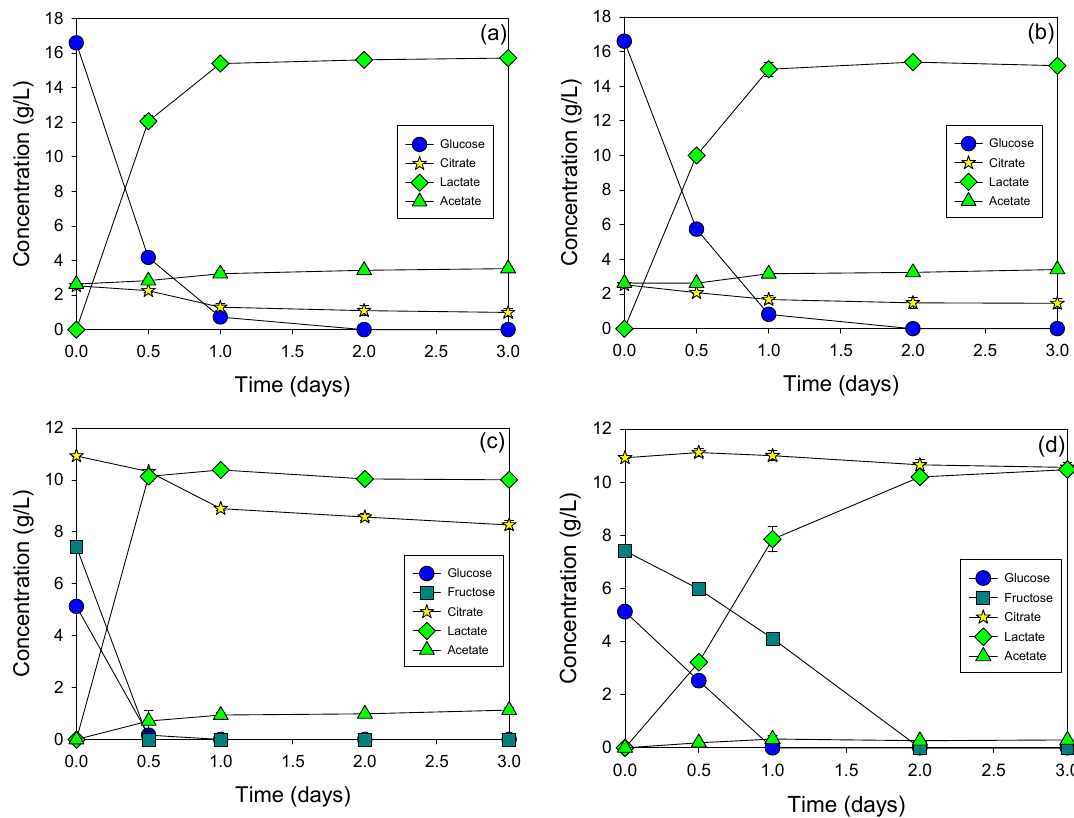
Figure 4. Growth of Lactobacillus plantarum ( a ) and Lactobacillus paracasei KCTC 13169 ( b ) in MRS medium and fermentation of synthetic cucumber extract by Lactobacillus plantarum ( c ) and Lactobacillus paracasei KCTC 13169 ( d ).